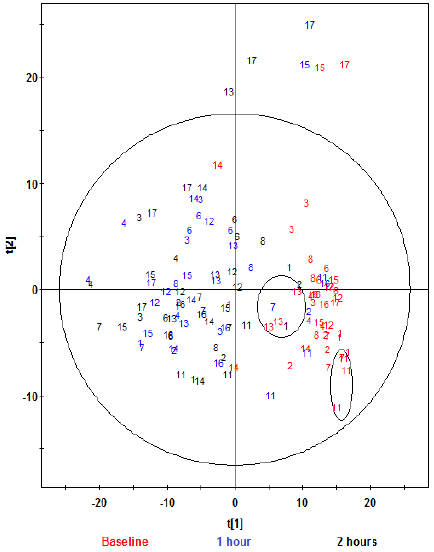
Figure 2. PCA scores plot t[1] vs. t[2] obtained from 1 H NMR spectra of urine samples of fourteen participants at baseline and at one and two hours after consumption of aleurone, bran or control treatments, showing the different time-points and participant identifying numbers. Observations ( n ) = 122 (17 participants were recruited, but participants 5, 9 and 10 did not enter the study. Samples from four participants gave poor quality spectra and were excluded (participant 2, aleurone, 2 h; participant 3, aleurone, 2 h; participant 4, control, 2 h; participant 8, bran, 1 h). The ellipse represents 95% confidence region of the model based on HotellingT 2 .